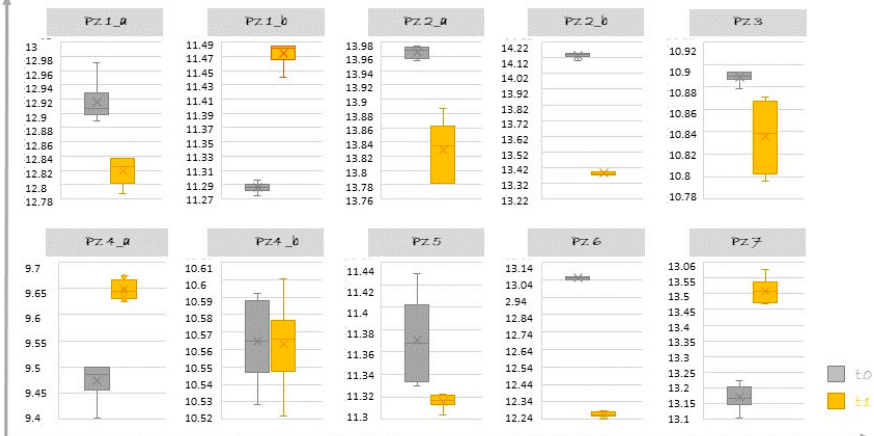
Figure 12. Comparison at t0 (baseline) and t1 (15 days post final restoration) of Crown Lengths (CL) distribution. On the ordinate axis, CL is expressed in millimeters.